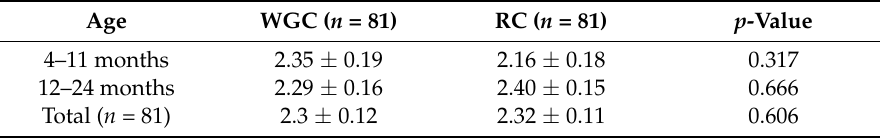
Table 4. Parent’s perception of child’s degree of liking (mean ± SEM).